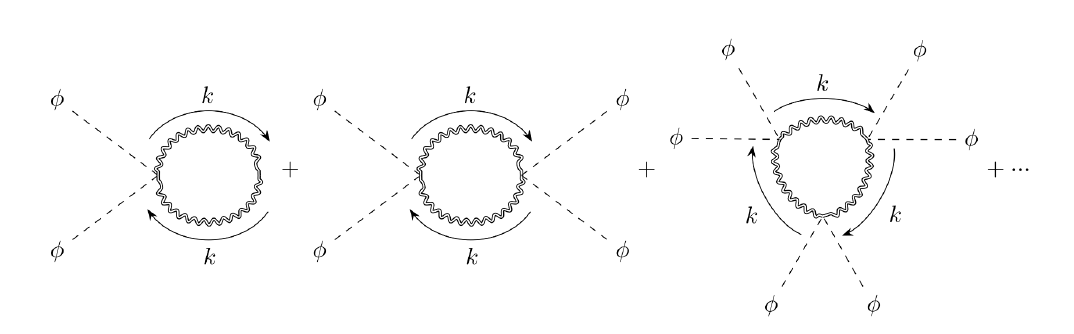
Figure 2 . 1PI diagrams of the interaction φ 2 h 2 that contribute to the potential in a loop approx-